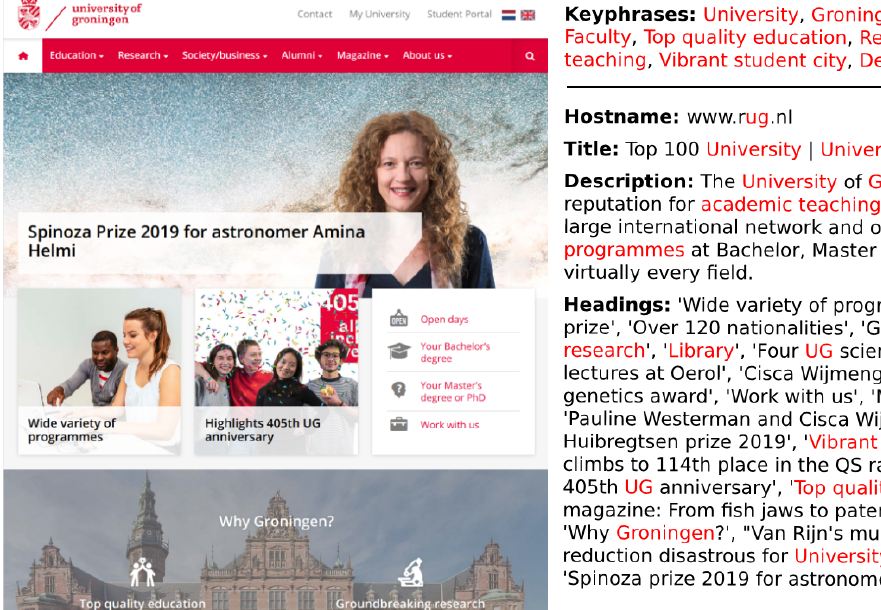
Figure 1. Top-10 keyphrases as extracted by WebEmbedRank from www.rug.nl, along with the parsed text from the important HTML elements. The keyphrases are marked in